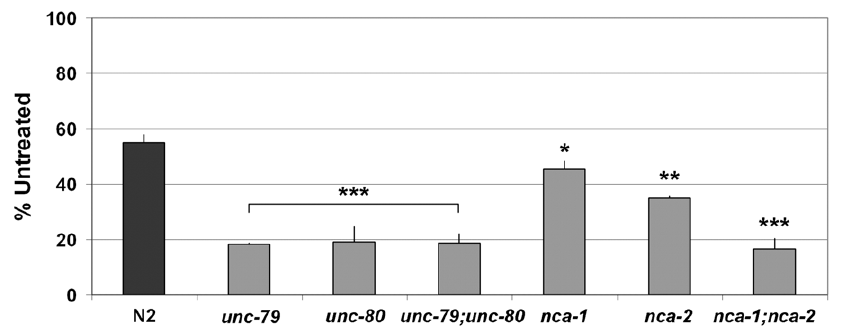
Figure 10. Swimming behavior is hypersensitive to ethanol in C.elegansunc-79 , unc-80 , and nca-1;nca-2 double mutants. Swimming sensitivity to ethanol (400mM). The mean relative frequency of body bends during swimming of wild-type (N2) and various mutants is shown. Error bars indicate SEM. Asterisk indicates a statistical difference as tested by Student’s t-test (* P , 0.05, ** P , 0.005, *** P , 0.0001).